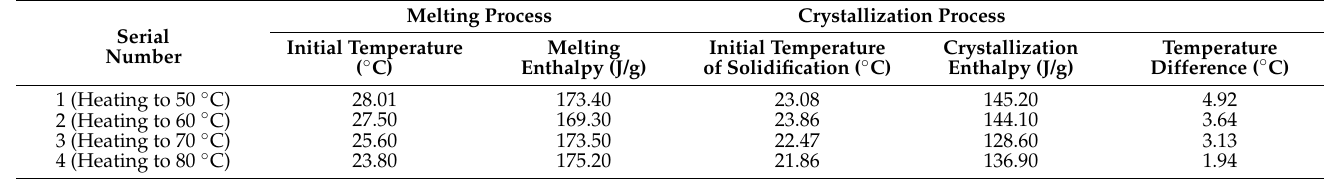
Figure 7. DSC characterization of phase transition properties of binary composite phase change materials at different heat storage temperatures ( a ) DSC curve of the second temperature rise. ( b ) DSC curve of the first cooling. Table 2. Thermal performance parameters measured by DSC curves at different heat storage temperatures.